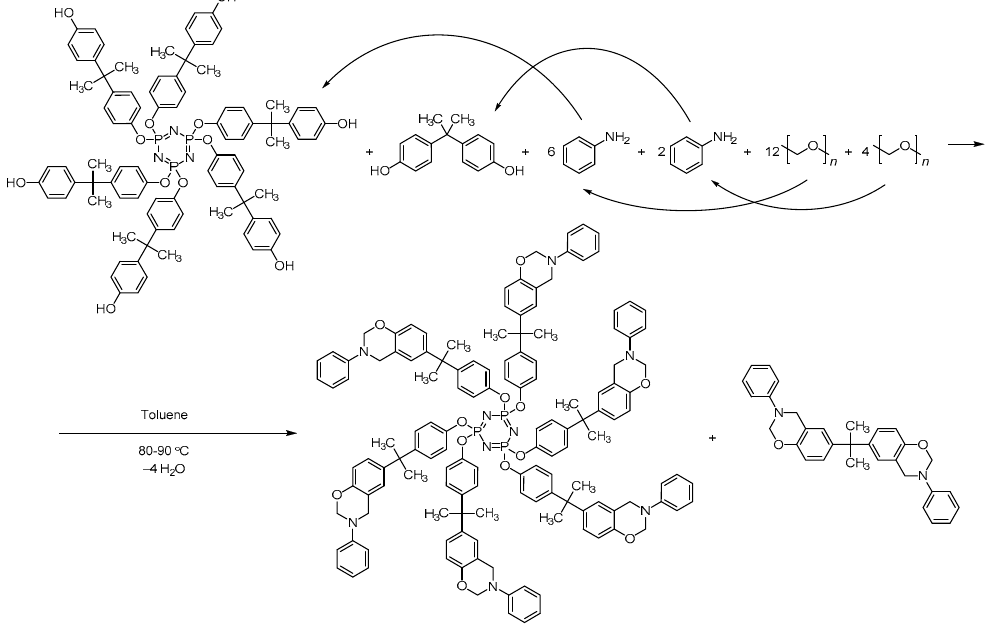
Figure 6. MALDI-TOF mass spectrum of hydroxyaryloxyphosphosphazenes synthesized at a molar ratio of HCP: bisphenol A = 1:12.